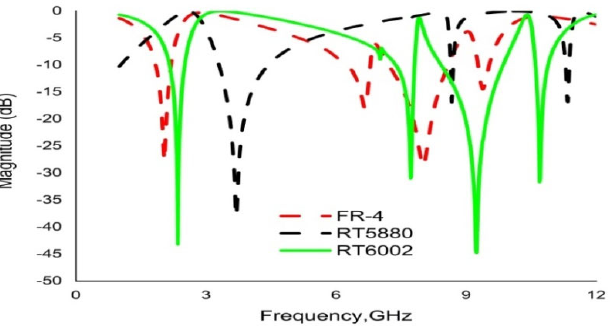
Figure 4. Transmission coefficients ( 𝑺 𝟐𝟏 ) for different substrate dielectric materials.